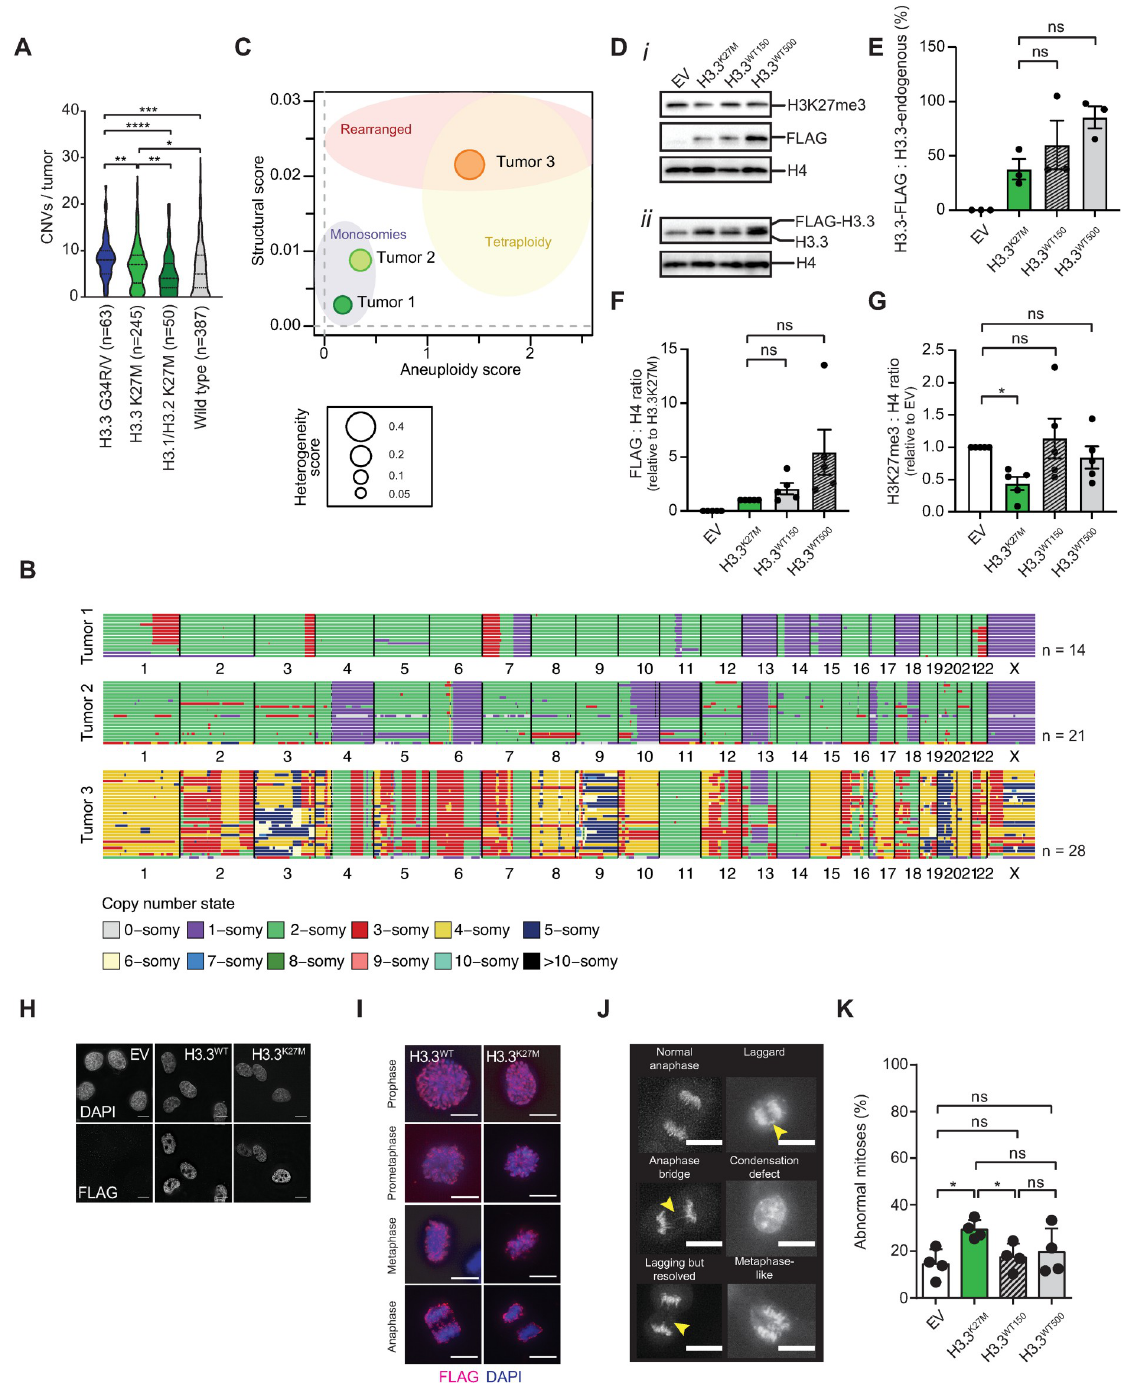
Fig 1. The H3.3K27M oncohistone is associated with aneuploidy, intratumor heterogeneity, and genomic and chromosomal instability. (A) Distribution of chromosome copy number variations (CNVs) across a set of pediatric high-grade gliomas (HGG). Data are represented as medians (— — —) and quartiles (----); � P = 0.0289, �� P = 0.0064 and P = 0.0066, ��� P = 0.002, ���� P � 0.0001 (Mann Whitney non-parametric t-test). Source data for this panel were derived from Mackay et al, Cancer Cell 2017, and re-used with permission [4]. (B) Single-cell Whole Genome Sequencing data for n = 14 (tumor 1), n = 21 (tumor 2) and n = 28 (tumor 3) cells from human H3.3K27M mutant pediatric HGG biopsies. Each line represents the karyotype of a single cell, organized by chromosome number. Colors represent ploidy. (C) Structure, aneuploidy and heterogeneity plot of n = 3 pediatric HGG tumors. The structural score (plotted on the Y- axis) represents the number of structural abnormalities observed in the tumor, as it quantifies the frequency of copy number changes